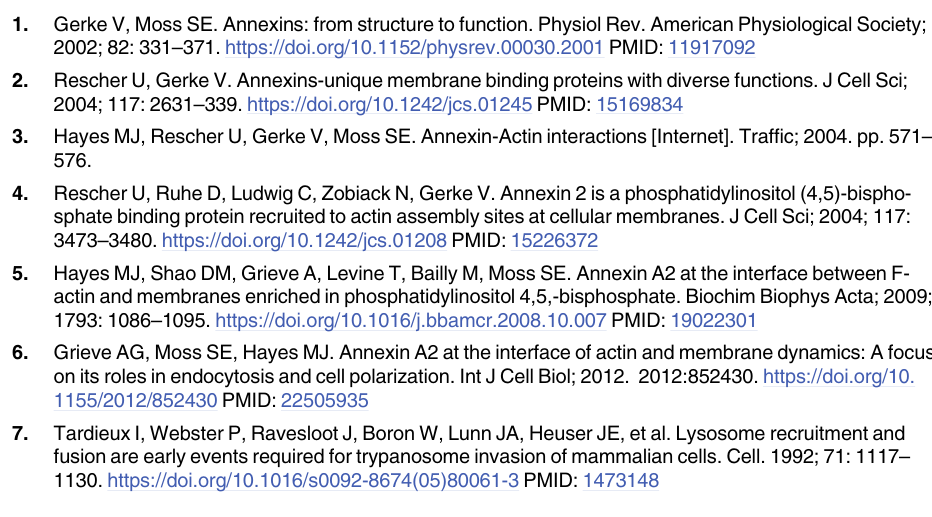
The amounts of intracellular parasites are shown as means ± SD of three independent assays performed in duplicate. S3 Fig. Activation of host cell PTK by MUC-G and G strain MT. HeLa cells were incubated for 30 min in absence or in the presence of MT or MUC-G at 40 μ g/ml. After washings, the cell extracts were analyzed by western blotting, using antibody directed to phosphorylated tyrosine proteins. Note the increased phosphorylation levels of protein bands in cells that interacted with MT or with MUC-G (black arrows). S4 Fig. Effect of diverse treatments of host cell on G strain MT invasion. HeLa cells were subjected to chlorpromazine treatment, intracellular K + depletion or cytoplasmic acidification, and then incubated with MT for 1 h, followed by internalized parasite quantification. Values are the means ± three independent assays performed in duplicate. MT invasion was signifi- cantly reduced in cells subjected to diverse procedures ( � P < 0.001, �� P <